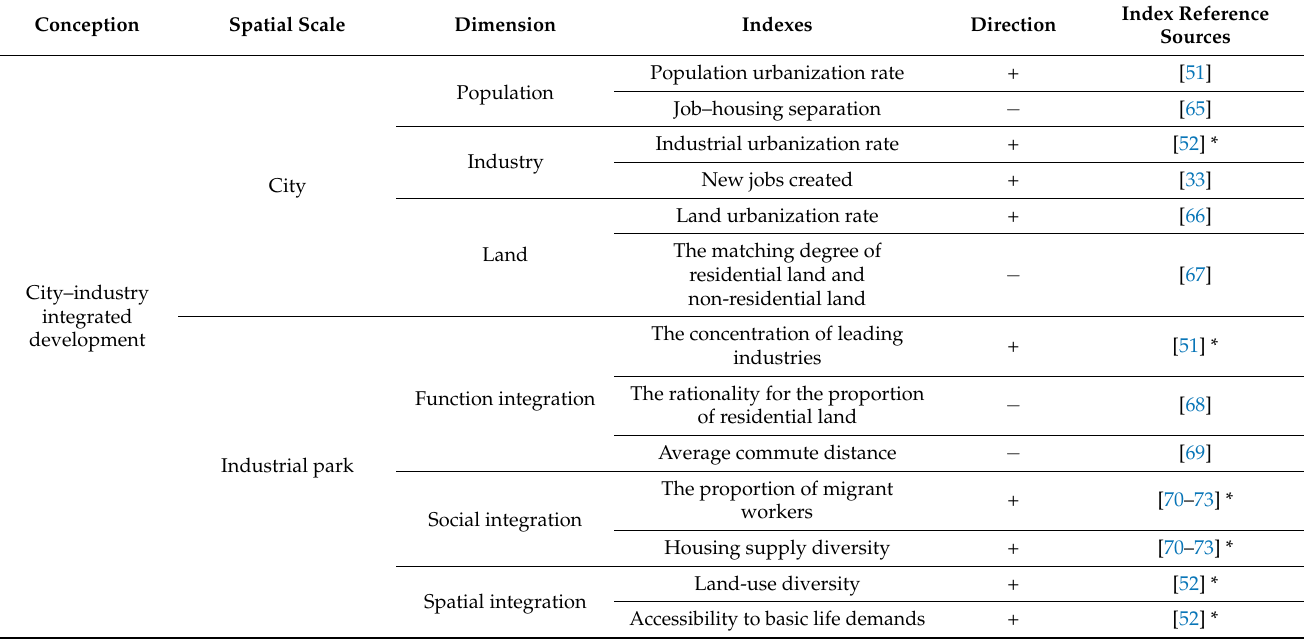
Table 1. An analytical framework of the two spatial scales for city–industry integration evaluation. Conception Spatial Scale